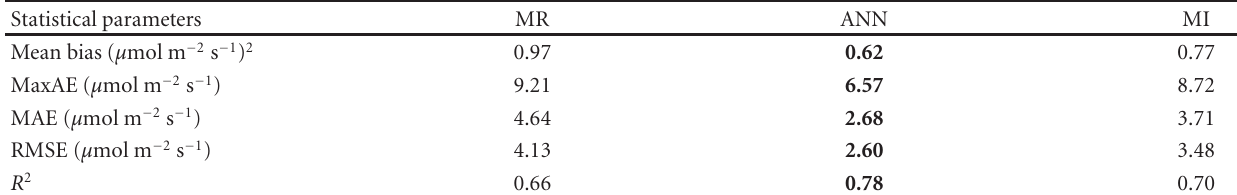
Table 5: Yearly average of statistical performance for MR, ANN, and MI gap-filling techniques. Statistical parameters